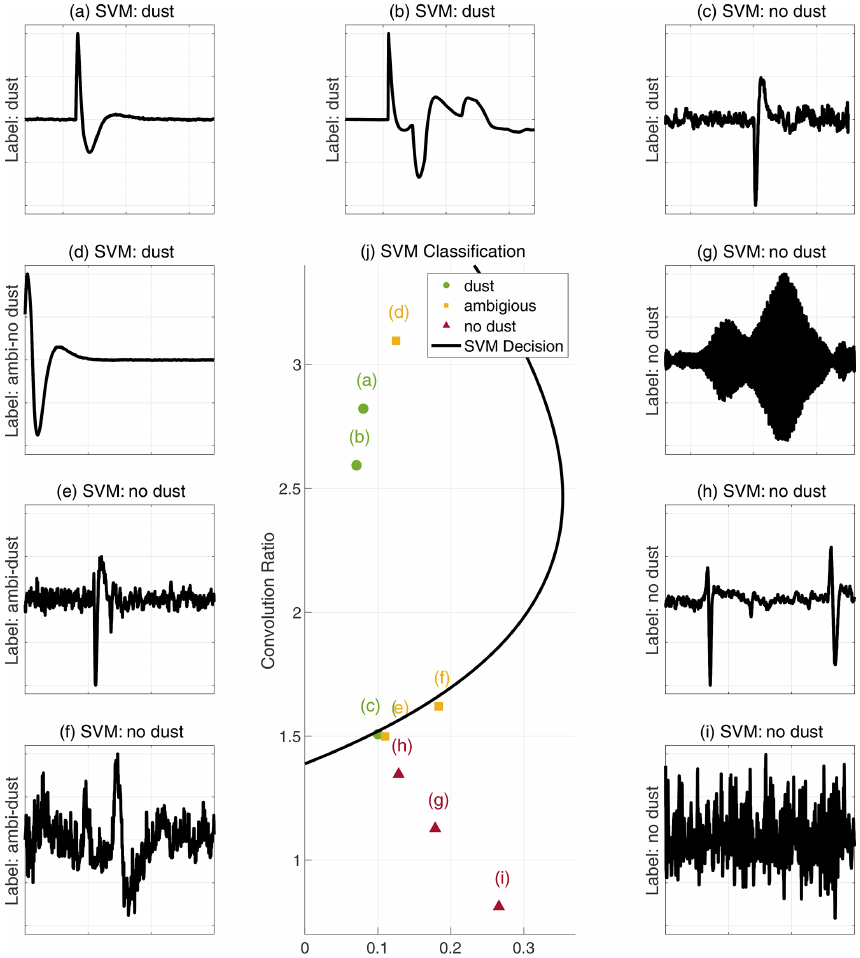
Figure 6. The signal examples are presented in (a) – (i) , the manual labels are indicated along the y axis and the predicted labels, classified by the SVM decision line, are presented in the subplot titles. Panel (j) presents the associated signal examples in the 2-D feature vector space along with the SVM decision line. The dust signals are illustrated in green, the ambiguous signals are marked in yellow and the no dust signals are indicated in red. The SVM classifier provides mostly explainable outputs. The clear dust signals (a–b) are located well within the SVM decision line, the ambiguous signals (e–f) are located near the decision line, while the no dust signals (g–i) are clearly located outside. However, dust signal (c) is erroneously located just outside the decision line, this can possibly be explained by the weak signal-to-noise ratio. In addition, signal (d) is located well within the decision line, although this signal is labeled ambiguous-no dust due to the signal framing, this indicates that the SVM might have difficulties classifying signatures located at the edge of the snapshot frame. Note that the signals are zoomed to 15ms intervals around the interesting features, similar to the examples in Fig.